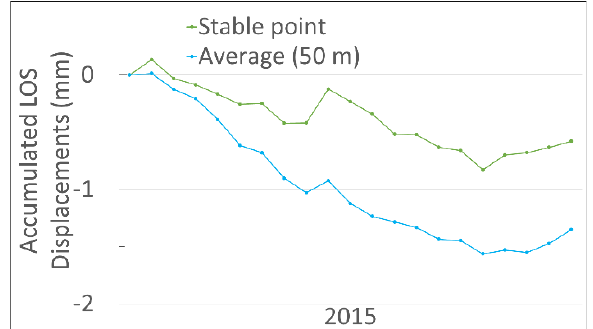
Figure 13. Displacement sequences of stable point (green) and average (blue) (Figure 11). Similarity between two sequences: Euclidean distance, 3 mm; Manhattan distance, 12 mm; Chebyshev distance, 1